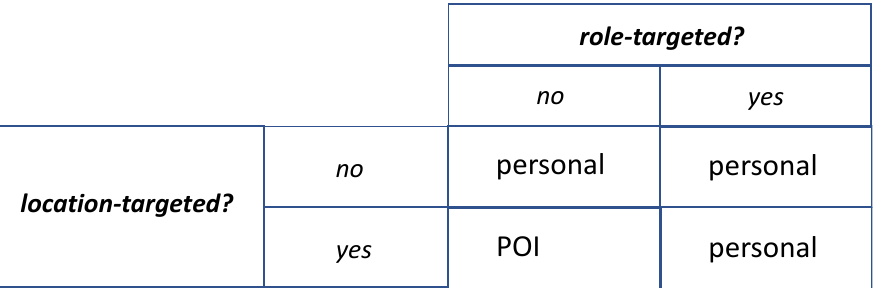
Figure 3. A possible mapping of different kinds of sensing requests to the delivery modes. Other mappings are possible, except for role-targeted requests, which require personal delivery.